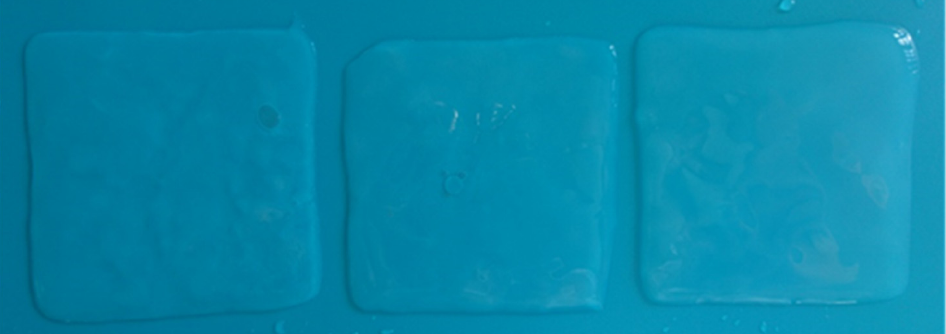
Figure 2. The aspect of the bacterial cellulose after purification.